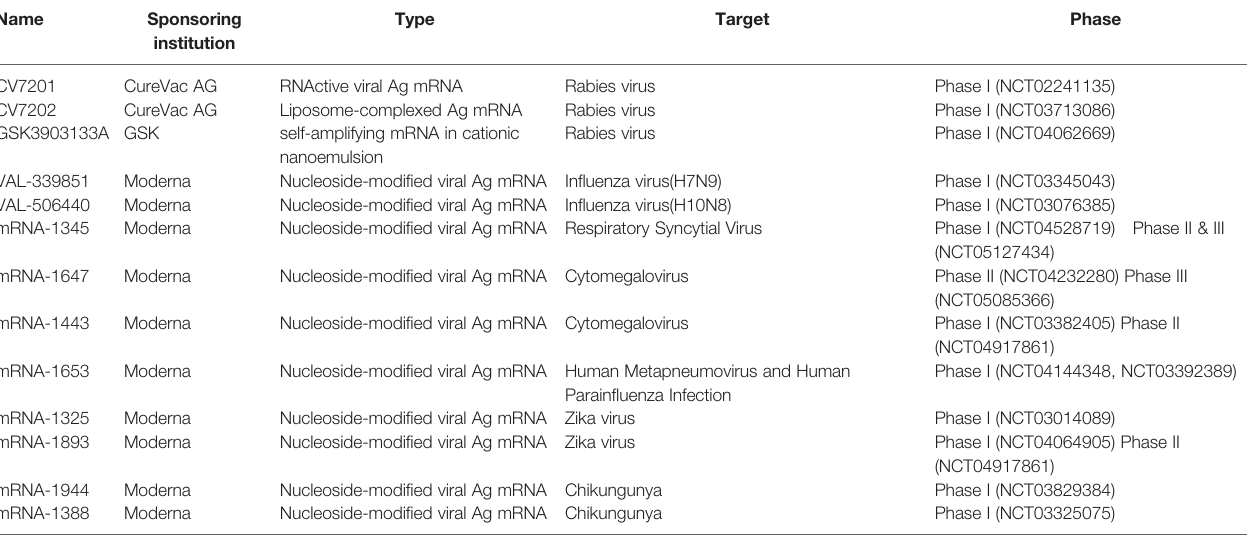
TABLE 1 | Clinical trials of mRNA vaccines against infectious